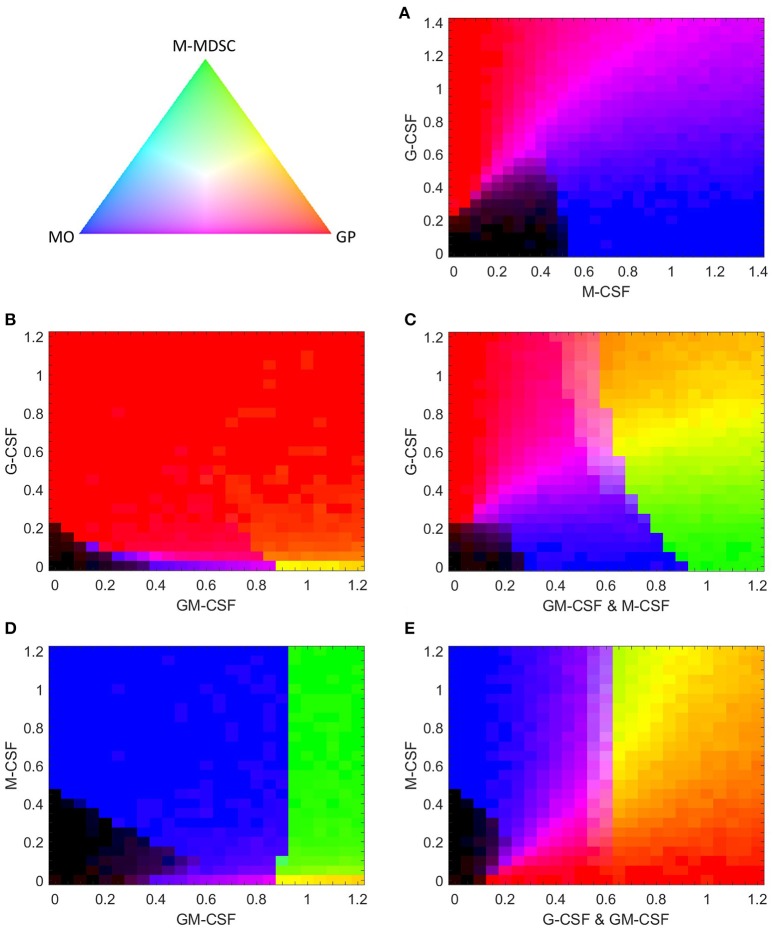
Simulated composition of stochastically generated populations of cells in response to various combinations of cytokines. Each cytokine combination is simulated with 500 stochastically generated cells. The color gradient triangle on the top left correlates to population composition. Populations containing all M-MDSCs, granulocyte progenitors (GP), or monocytes (MO) are represented by green, red and blue, respectively. Black represents populations of undifferentiated cells. The mathematical relationship between population ratios and pixel color is discussed in “computational methods”. (A,B) G-CSF paired with M-CSF or GM-CSF. (C) G-CSF paired with equal concentrations of GM-CSF and M-CSF. (D,E) M-CSF paired with GM-CSF or with equal concentrations of G-CSF and GM-CSF.